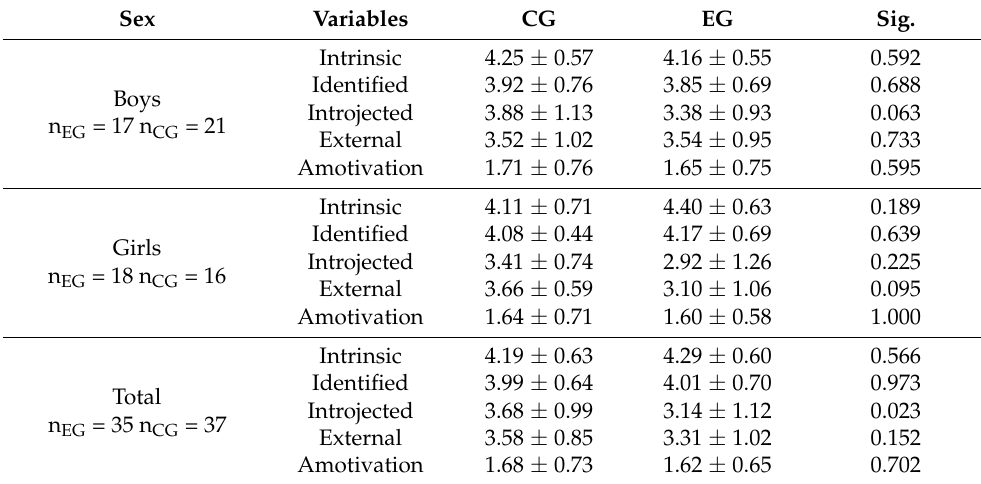
Table 2. Pre-test differences in different regulation variables between the CG and the EG (Av ± SD) in the entire sample and segmented by sex.